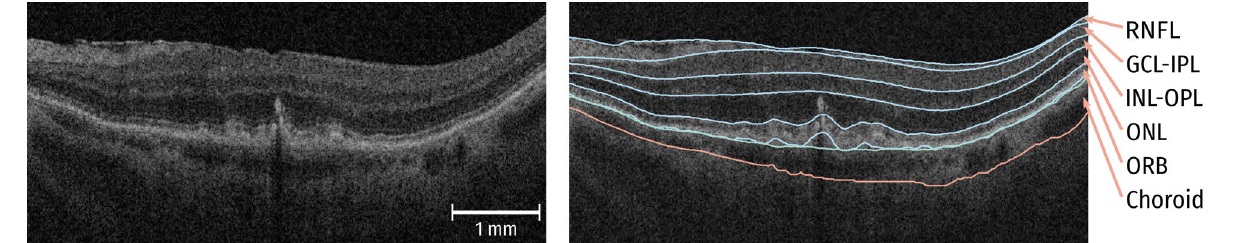
Figure 2. Example of automatic layer segmentation. 6 retinal layers and the choroid are segmented. Retinal nerve fibre layer (RNFL), ganglion cell layer (GCL), inner plexiform layer (IPL), inner nuclear layer (INL), outer plexiform layer (OPL), outer nuclear layer (ONL), and outer retinal hyperreflective bands (ORB) comprising retinal pigment epithelium and outer photoreceptor